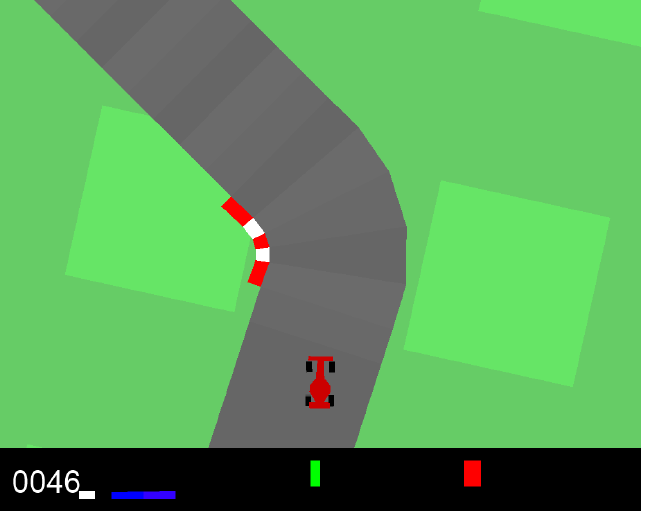
Figure 2. Experimental scenario. In the image from left to right, colors depict velocity (white), the four ABS sensors (blue and purple), the position of the steering wheel (green), and the gyroscope (red).